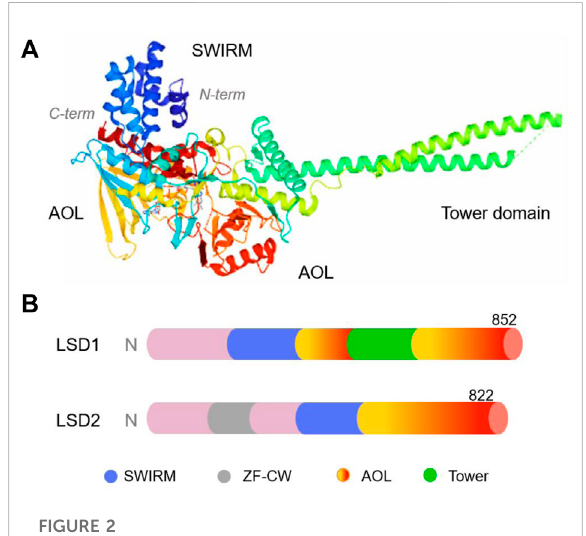
FIGURE 2 The structure of human lysine-speci fi c demethylase (LSD) protein. (A) Three-dimensional structure of human LSD1 protein (PDB No.: 2Z5U), Copyright © 2007 Elsevier Inc. (B) Schematic illustration of the structure of LSD1 and